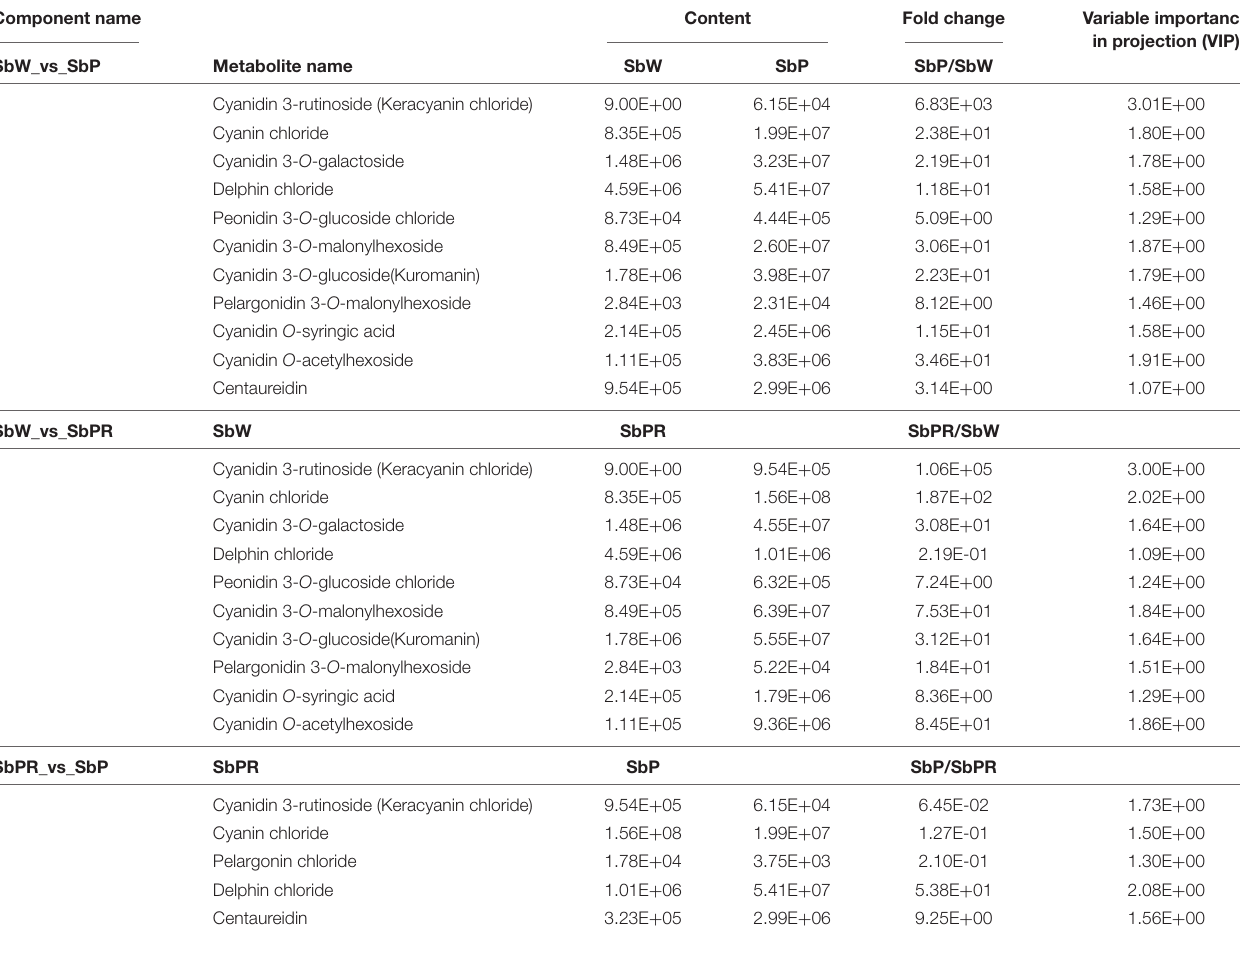
TABLE 1 | Differential accumulation of anthocyanins in the flowers of Scutellaria baicalensis ‘white petals’ (SbW), ‘purple-red petals’ (SbPR), and ‘purple petals’